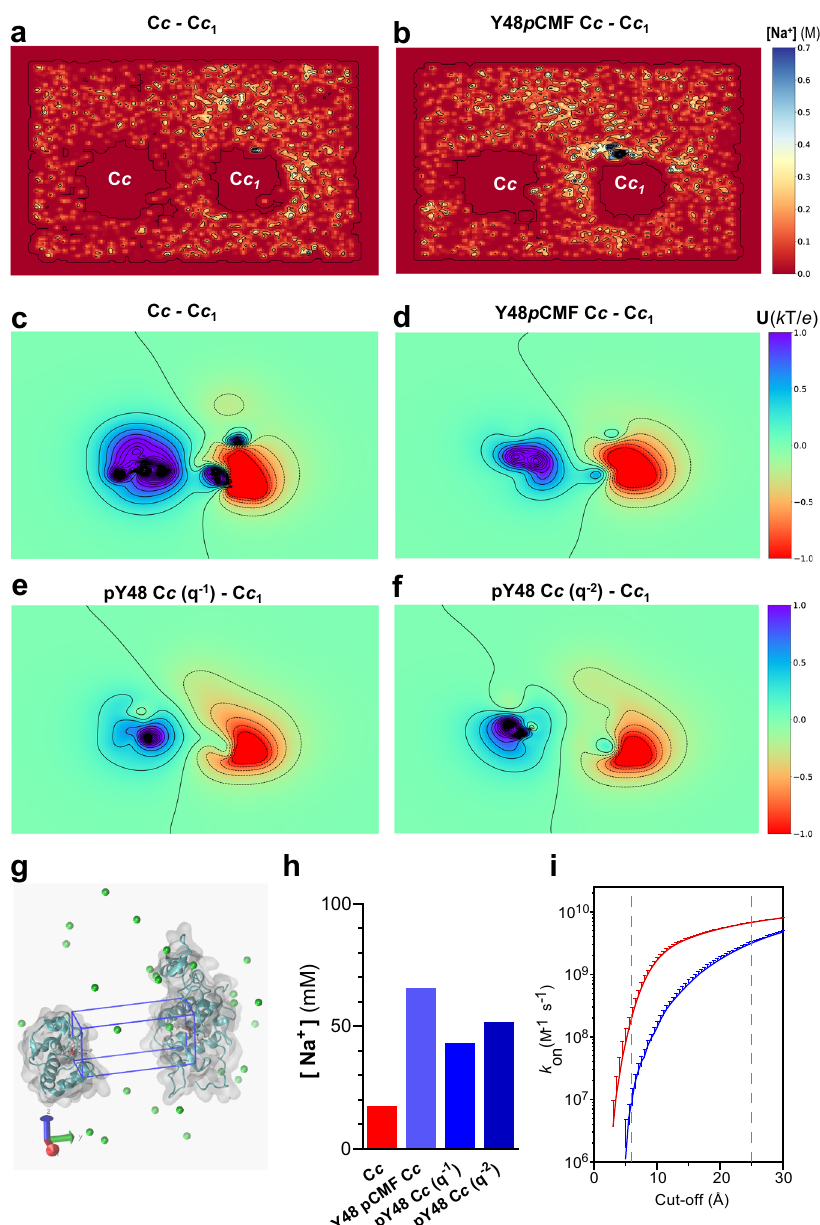
Fig. 4 | Molecular dynamics (MD) calculations of C c 1 and C c display an inter- proteinGouy-Chapmanconduitthatisdisruptedbyphosphorylation.a , b Side view of the averaged sodium concentration map (M) at the X-axis plane dissecting bothC c 1 - C c redoxactivesites(C c andY48 p CMFC c ,respectively)facingeachother at3.2nmseparationtaking themostexternalhydrogenatomsfromthe -CH 3 distal pairs from each heme group, that is 4.2nm taking the Fe-to-Fe distance. MD simulations were performed with explicit water (TIP3P solvent model) and 50mM ionic concentration (NaCl) over 36ns. Each contour line displays an increase of 0.15M.( c – f )SideviewofcomputedelectrostaticpotentialwithAPBS 76 from – 1kT/e (red) to 1 kT/e (blue) for C c 1 -C c pairs: C c 1 -C c (c) , C c 1 -Y48 p CMF C c in silico (d) , C c 1 - pY48C c (O-phospho-L-tyrosine)with charge – 1 (e) and C c 1 -pY48 C c (O-phospho-L- tyrosine) with charge – 2 (f) . Ion concentration is 50mM, pH 6.5. Each contour line displays an increase of 0.2 kT/e. g Virtualization of the C c 1 -C c system in 3D. Representation of the prism (blue) used to calculate the average concentration of